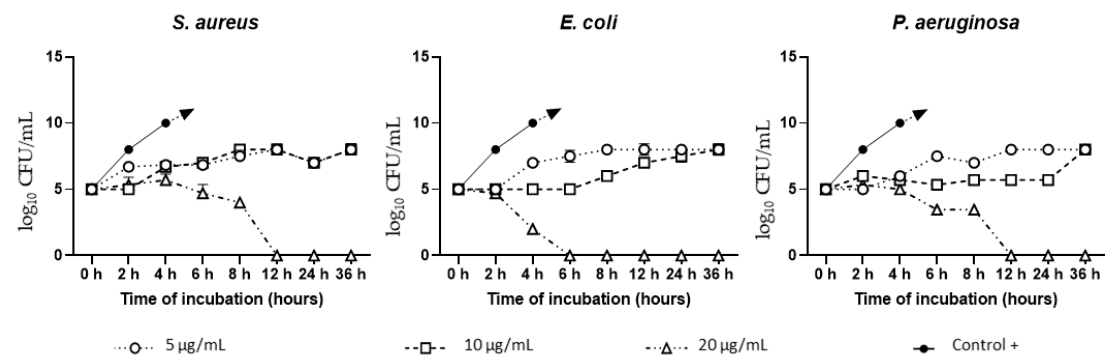
Figure 2. The time-dependent growth curves of bacteria after co-cultivation with different concentrations of AgNAs. In the positive controls (Control +) of all three bacterial species, log 10 CFU/mL was > 8 since the 4 h time point.